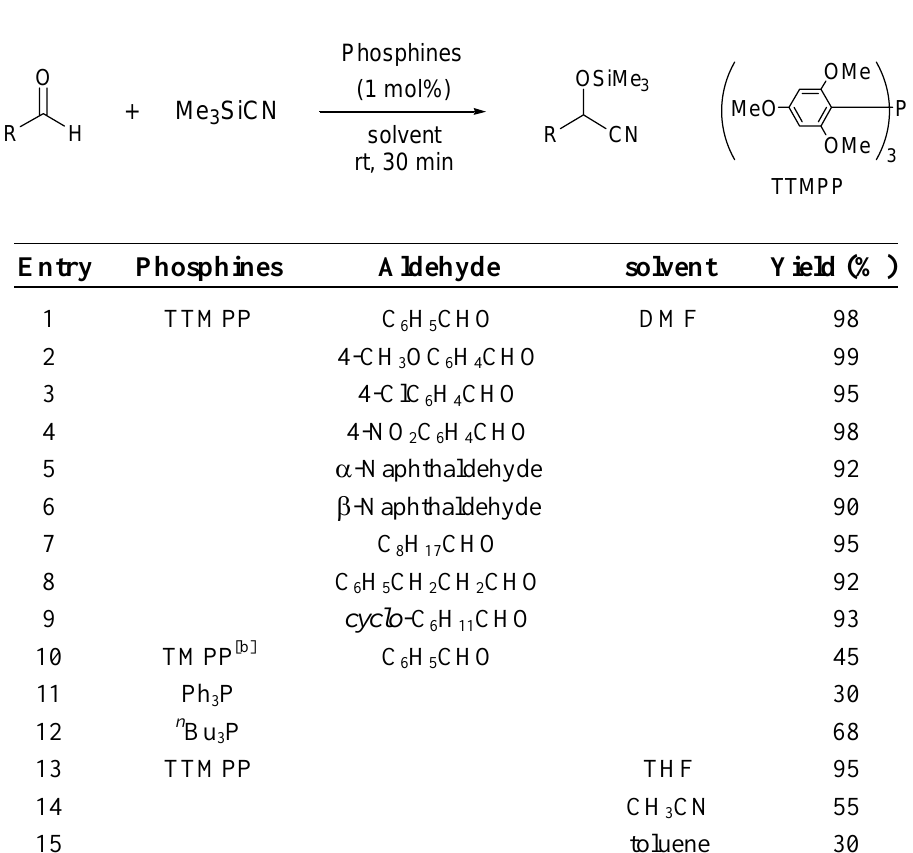
Table 1. Cyanosilylation of various aldehydes.